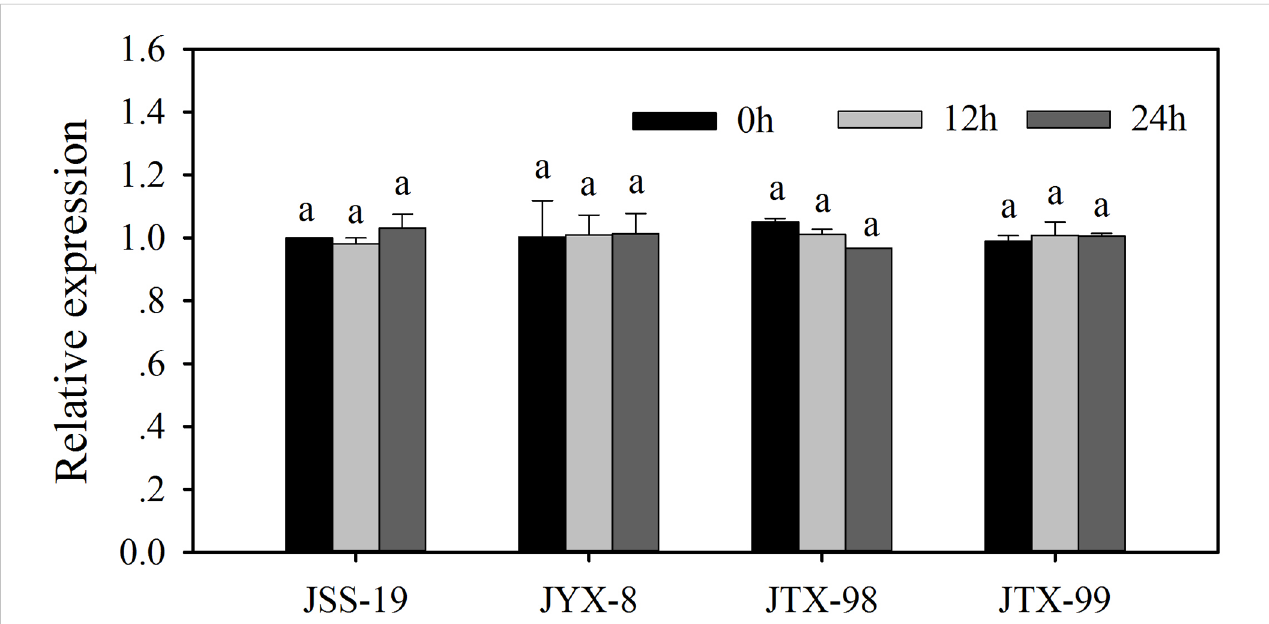
FIGURE 3 ACCase gene expression in four populations of D . ciliaris var. chrysoblephara after metamifop treatment. Gene expression levels were quanti fi ed by RT- qPCR and were not signi fi cantly different between control and metamifop treatments, both in the sensitive and resistant populations. Vertical bars indicate standard errors. The same lowercase letters indicate the lack of statistically signi fi cant differences based on Tukey ’ s